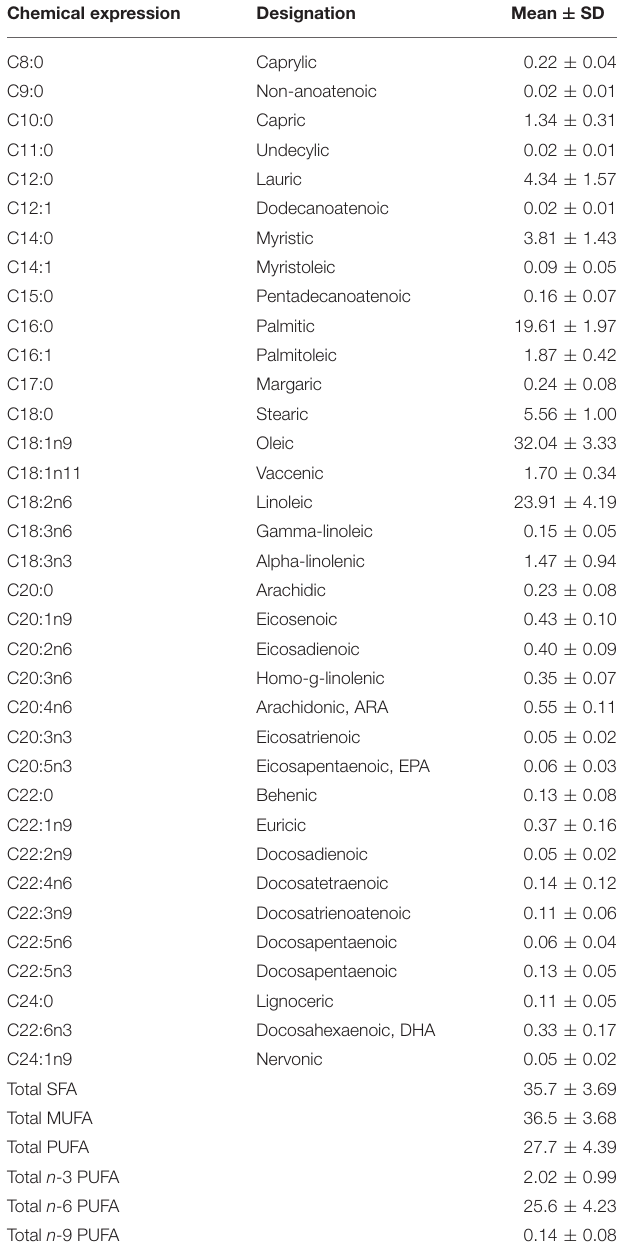
TABLE 4 | Fatty acid composition in breast milk. Chemical